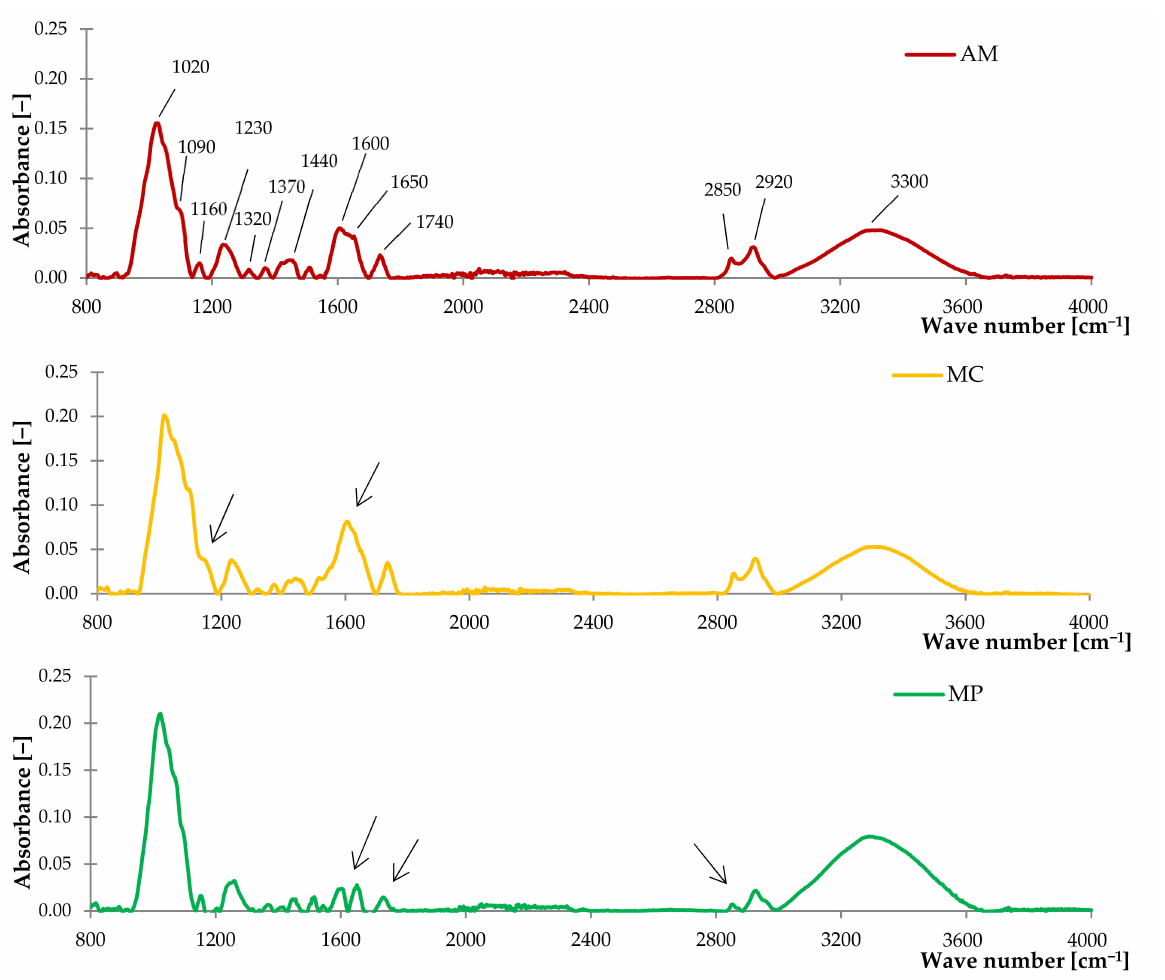
Figure 1. The FTIR spectra of yarrow (AM), German chamomile (MC) and peppermint